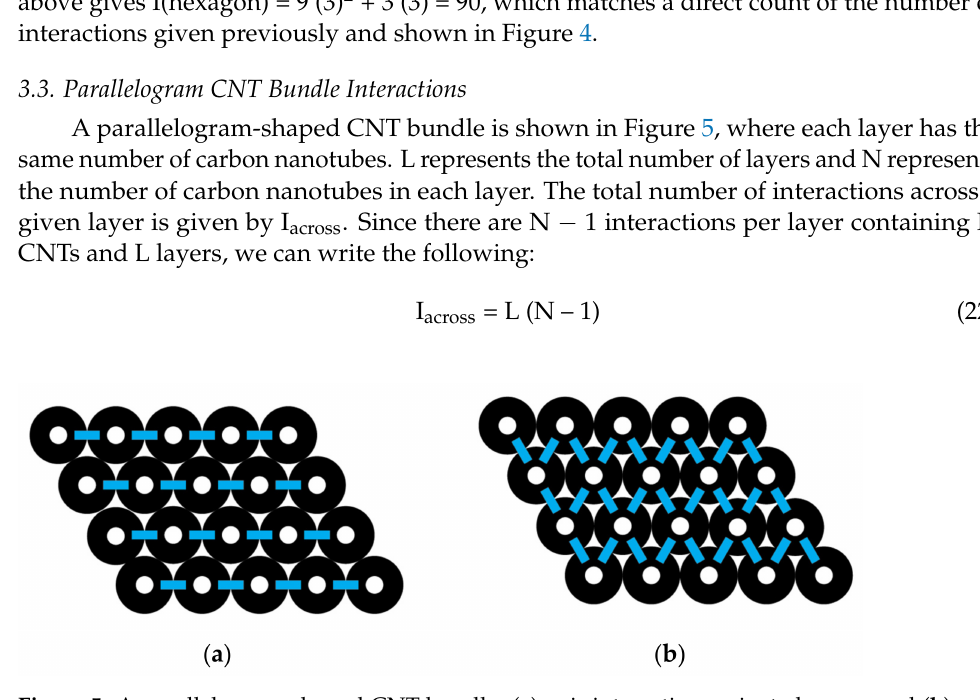
Figure 5. A parallelogram-shaped CNT bundle: ( a ) pair interactions oriented across and ( b ) pair interactions oriented